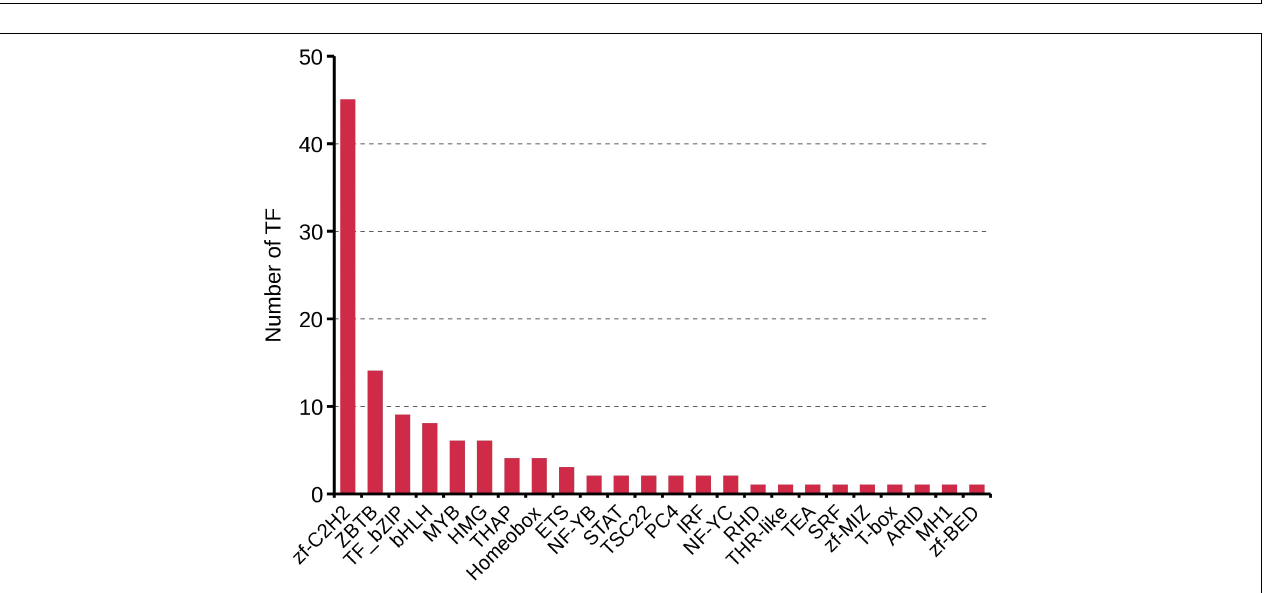
FIGURE 4 | Identification of AS and APA events based on the SMRT sequencing. (A) Number and categories of the AS events identified. (B) Distribution of the number of poly(A) sites per gene.